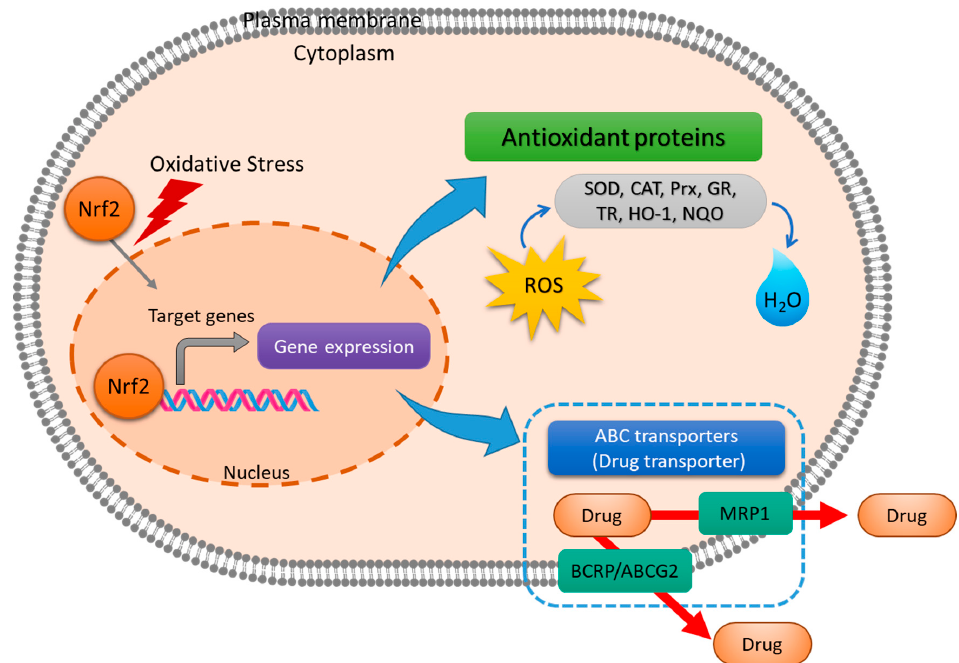
Figure 2. Nuclear factor erythroid 2-related factor 2 (Nrf2) regulates redox-homeostasis and catalase (CAT), peroxiredoxin (Prx), glutathione reductase (GR), thioredoxin reductase (TR), heme oxygenase-1 (HO-1), and NAD(P)H quinone oxidoreductase 1 (NQO). Multidrug resistance protein (MRP1)andbreastcancerresistanceprotein / ATP-bindingcassettesubfamilyGmember2(BCRP /